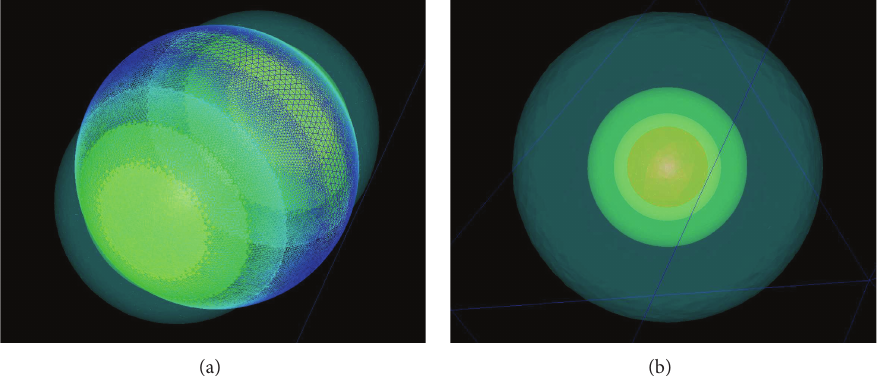
Figure 9: Isosurfaces of the intensity of electric field (a) and temperature (b), after adaptive remeshing with 𝐴 1 strategy ( 𝑁 8 = 3380 792 tetrahedra).